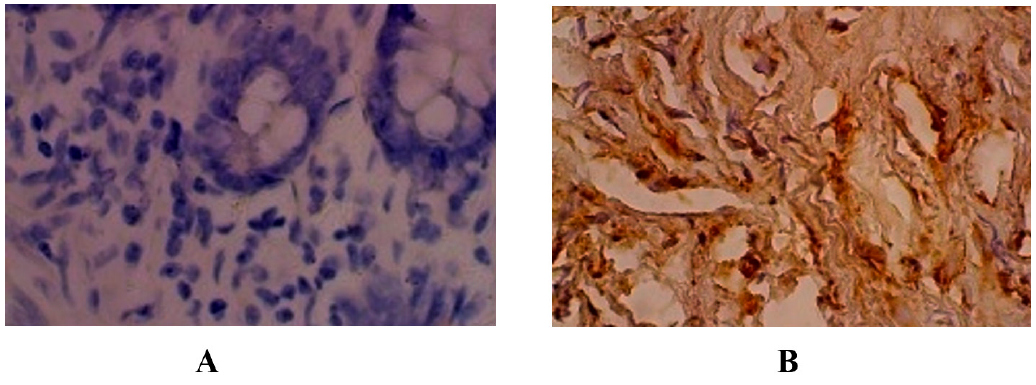
Fig. 2. Oral sections in OSCC: IHC staining of P16 protein ׳40. (A): Negative reaction; (B) positive